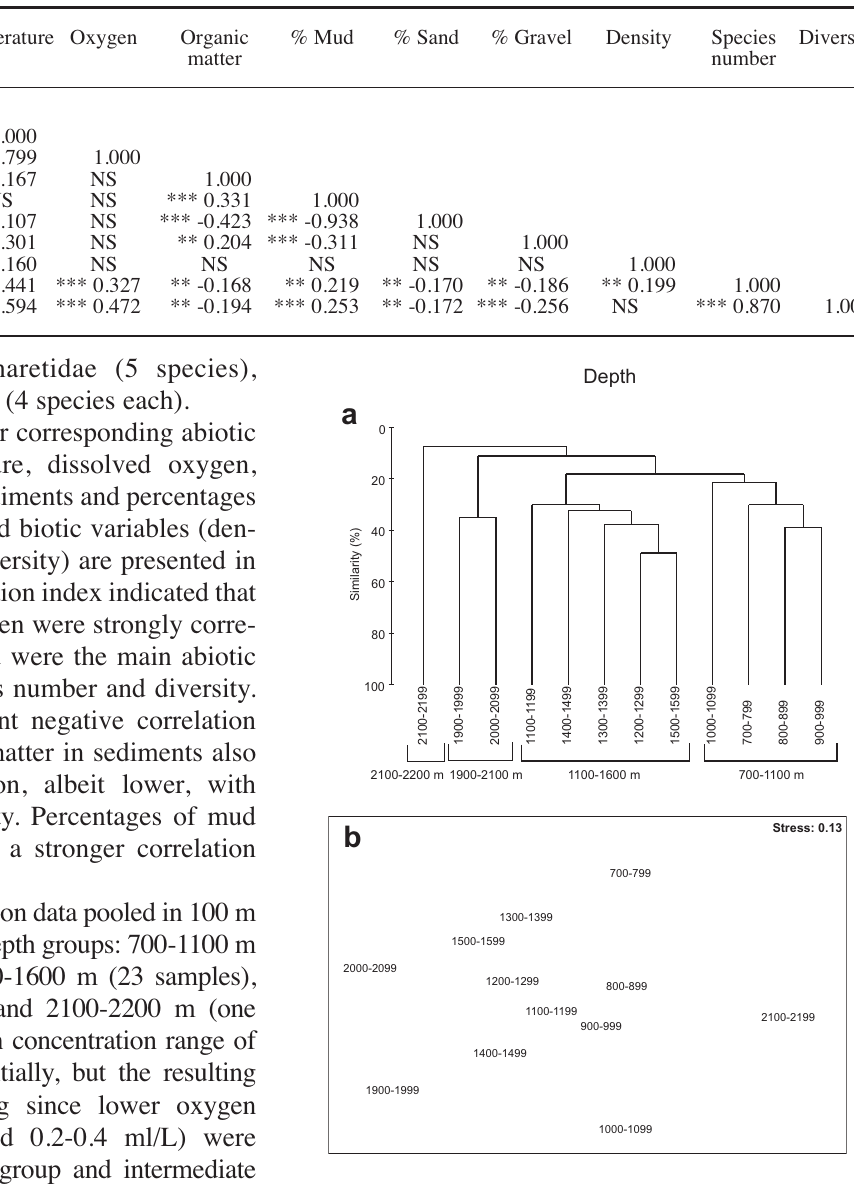
F IG . 2. – Depth ranges (grouped to the nearest 100 m) according to polychaete densities. a) Dendrogram (Bray-Curtis similarity index; group average link); b) Non-metric multi-dimensional scaling